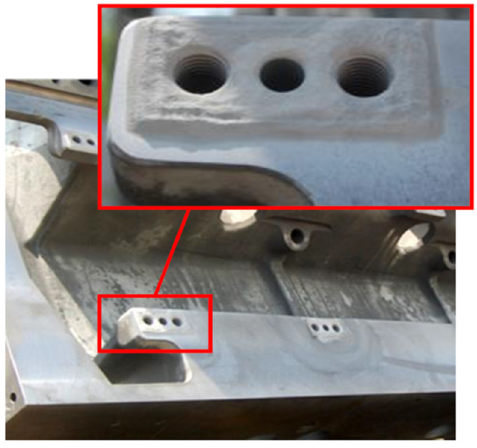
Figure 21. Dimensional restoration of an iron engine block mount [63].